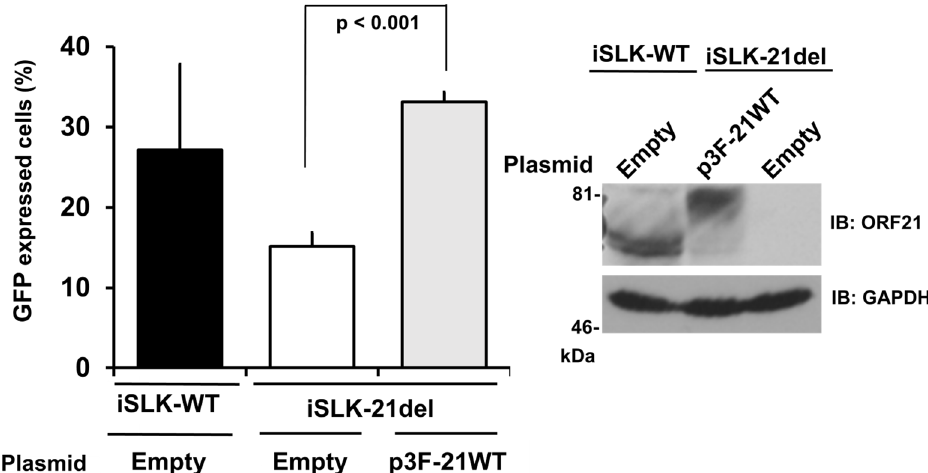
Figure 6. Infectious virus production in iSLK-21del cells is rescued by ORF21 overexpression. To validate the rescue of infectious virus production in iSLK-21del cells by exogenous ORF21 expression, iSLK-21del cells were transiently transfected with the 3 × Flag-ORF21 wildtype (p3F-21WT) plasmid (or empty plasmid) and treated for 96 h with Dox and NaB to produce recombinant KSHV. The culture supernatant was ultracentrifuged to precipitate the produced viruses, which were inoculated onto 293T cells. The infected cells (GFP-positive cells) were analyzed using a flow-cytometer, and the infectivity of the recombinant viruses is shown as a bar graph. p < 0.001 indicates a statistically significant difference compared with the empty plasmid-transfected cells. The endogenous or exogenenous ORF21 expression was analyzed by Western blotting using the anti-ORF21 polyclonal antibody. The original images are shown in Supplementary Figure S3.